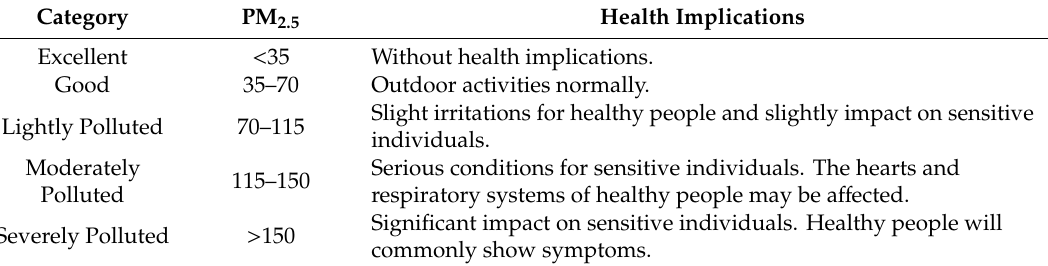
Table 5. PM 2.5 concentrations and health